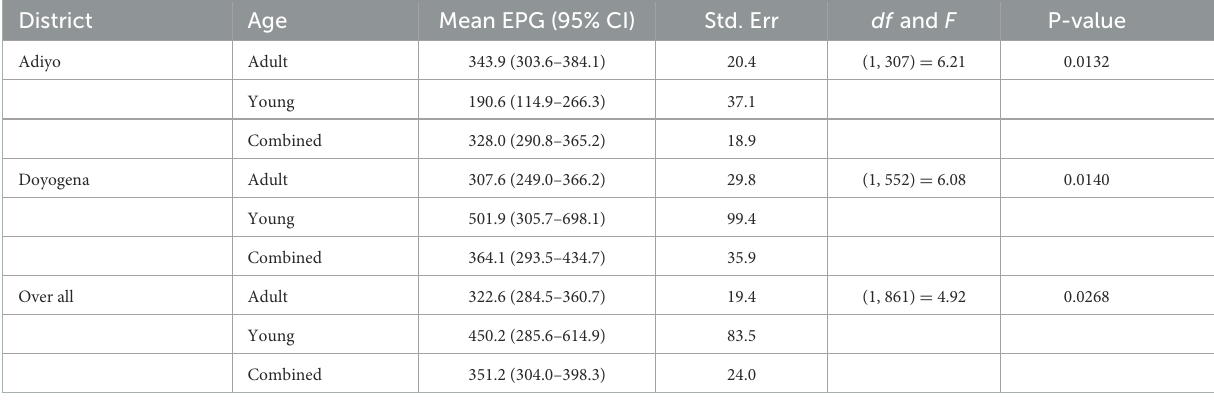
TABLE 4 Mean egg count, by age and district.